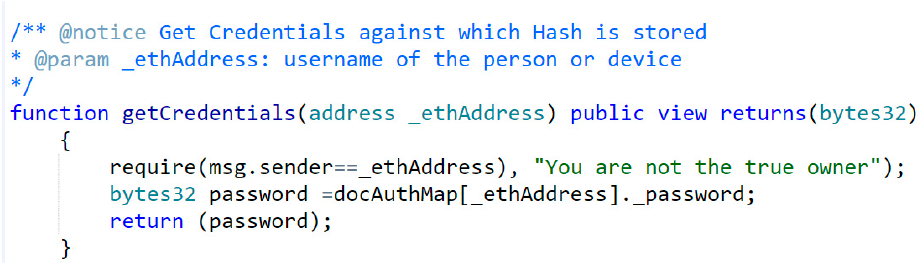
Figure 17. Authentication process Code Snippet.